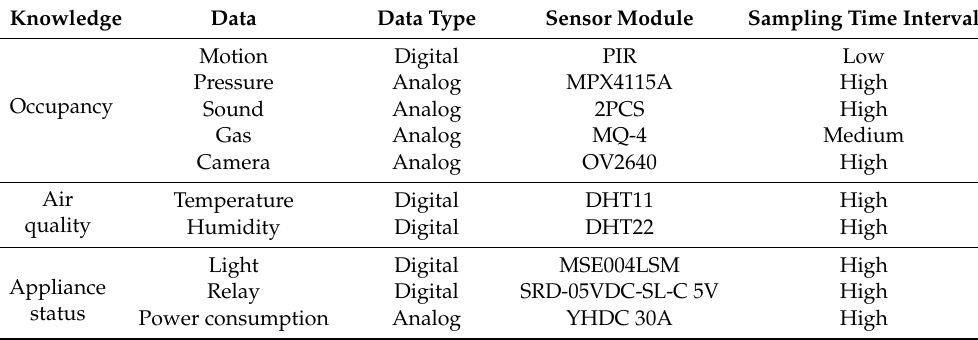
Table 9. Knowledge based on di ff erent sensor